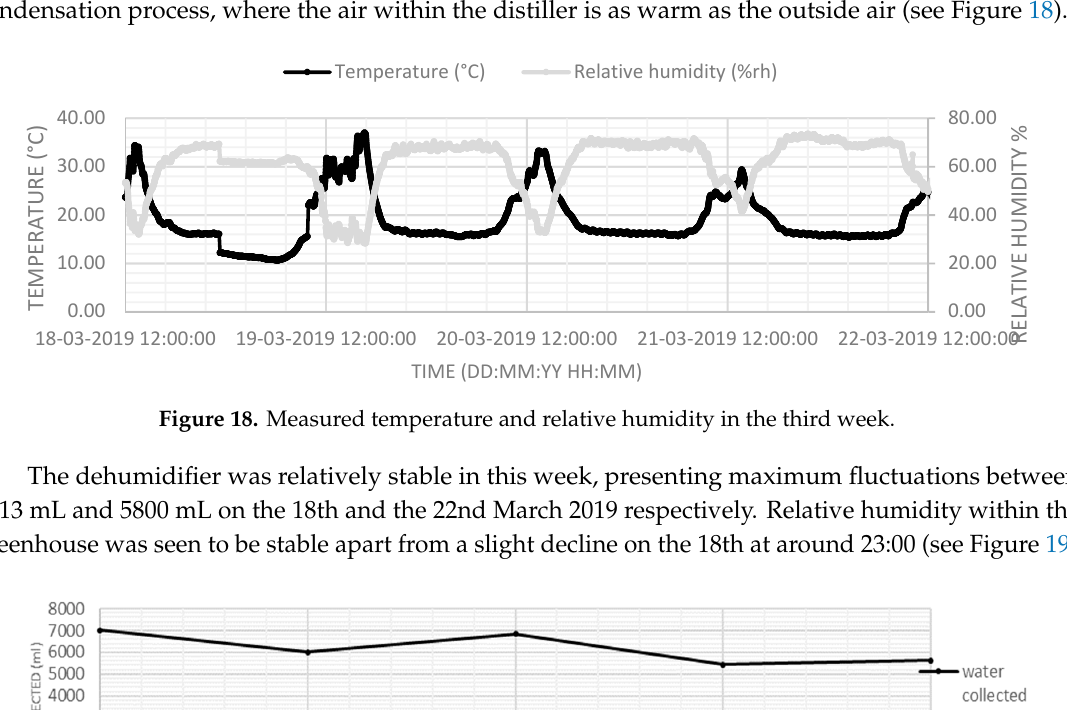
Figure 17. The measured solar intensity in the third week.